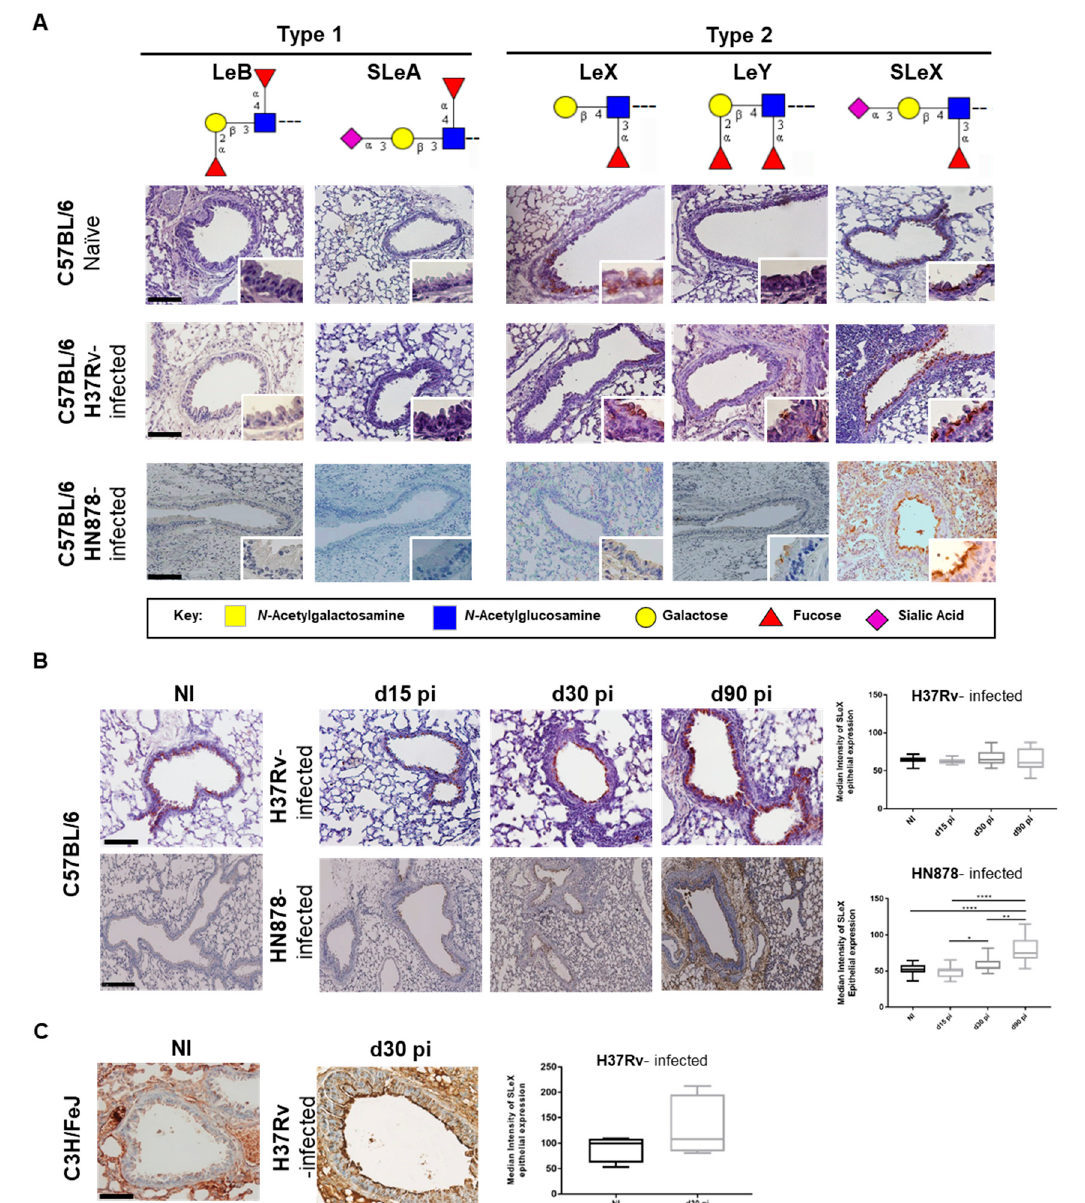
Figure 1. M. tuberculosis infection upregulates Silayl-Lewis X (SLeX) expression in lung tissue. ( A ) Lungs of C57BL/6 mice non-infected or infected after 90 days with two different M. tuberculosis strains (H37Rv or HN878) were stained by immunohistochemistry, using a panel of mAbs recognizing type 1 (Lewis B (LeB) and Sialyl-Lewis A (SLeA)) and type 2 (Lewis X (LeX), Lewis Y (LeY) and Sialyl-Lewis X (SLeX)) Lewis antigens. Magnification 200 × and inserts at 400 × . ( B ) SLeX expression on lung epithelium of non-infected or infected C57BL/6 and C3HeB/FeJ mice. C57BL/6 animals were infected via aerosol with M. tuberculosis H37Rv or HN878 strains. Lungs were recovered at the indicated time-points, fixed and lung sections stained for SLeX. Magnification 200 × . The right panel represents the quantification of epithelial expression of SLeX. ( C ) C3HeB/FeJ mice were infected intravenously with M. tuberculosis H37Rv strain. Lungs were recovered at the indicated time-points, fixed and lung sections stained for SLeX. Magnification 200 × . The panel on the right represents the quantification of epithelial expression of SLeX. Each dot represents the median intensity obtained per photograph. At least 5 mice were analyzed. Statistical analysis was performed using one-way ANOVA with Mann-Whitney test for multiple comparisons. *, p < 0.05; **, p < 0.01; ****, p < 0.0001. Monosaccharide symbols follow the Symbol Nomenclature for Glycans